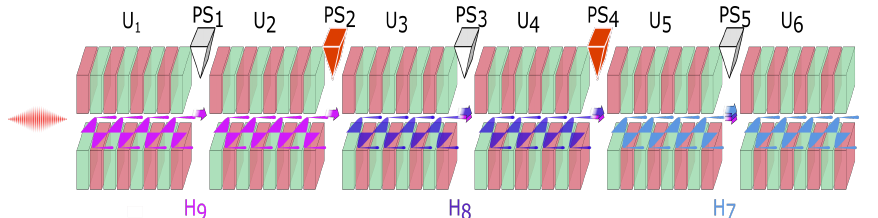
Figure 1. Undulator configuration for the three harmonics’ generation. Each harmonic is generated using a pair of undulators. The harmonics H 9 , H 8 , and H 7 are generated by the undulators U 1 and U 2 , U 3 and U 4 , and U 5 and U 6 , respectively. The phase shifters used to conduct a phase scan are indicated in red.